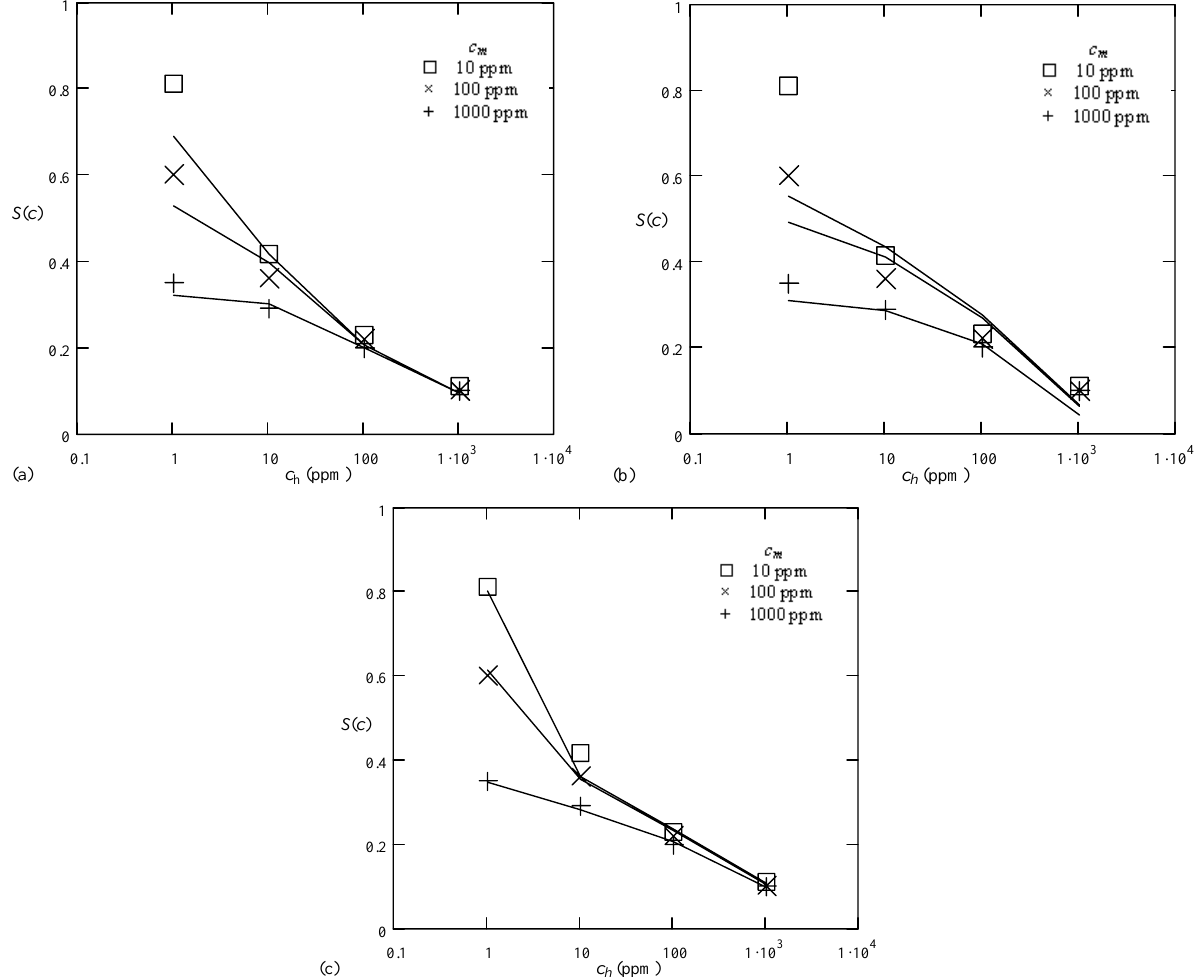
Figure 3. Relationship between estimated values and measured data for a gas mixture of CH using (a) the model of Clifford, (b) the model of Morrison and (c) the logarithmic model. The logarithmic model supplies better results compared with the models of Clifford and Morrison. S ( c ): the sensor relative conductivity, c